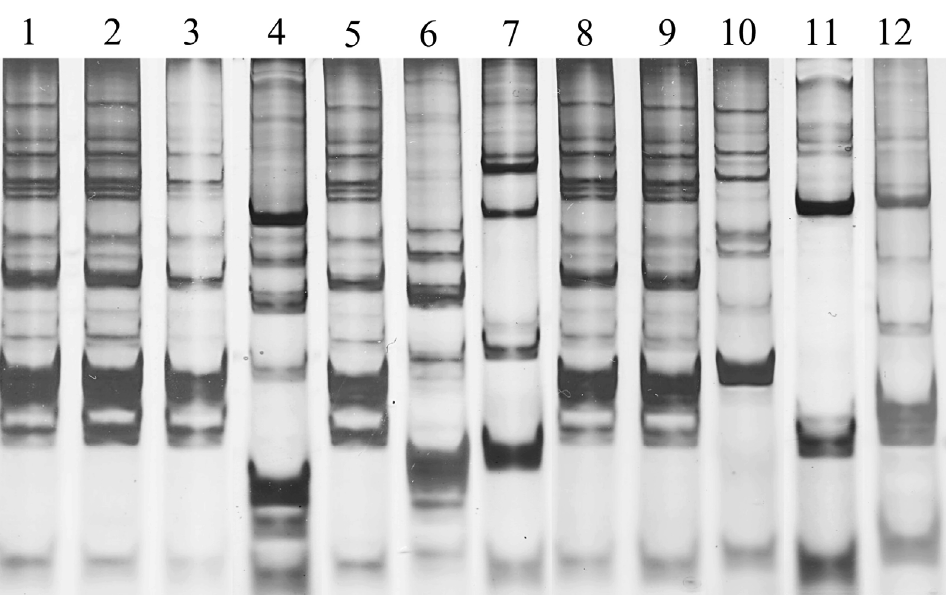
Figure 3. DNA fingerprint profiles of L. paracasei SD1 contained in milk powder (lane